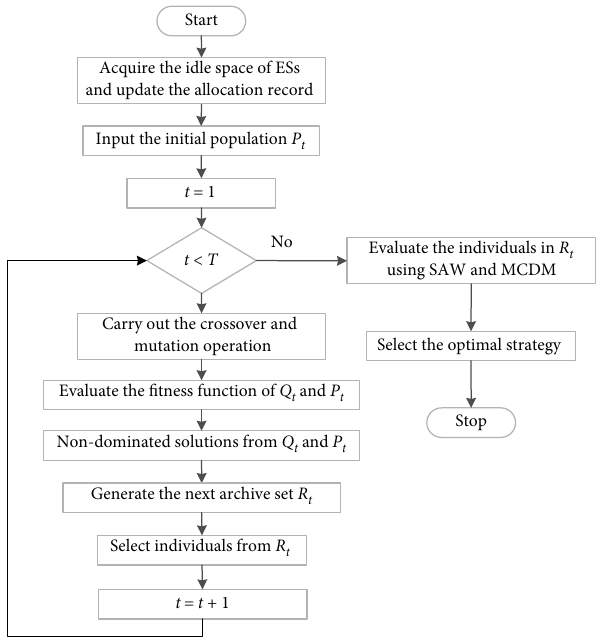
Figure 4: The flow chart of selecting the optimal strategy.